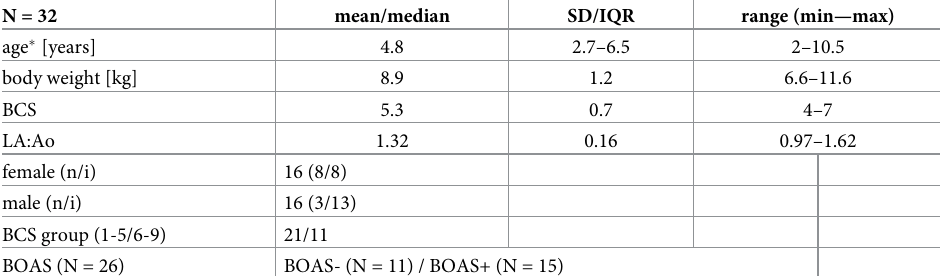
Table 2. Demographic data of 32 pugs included in radiographic measurements.